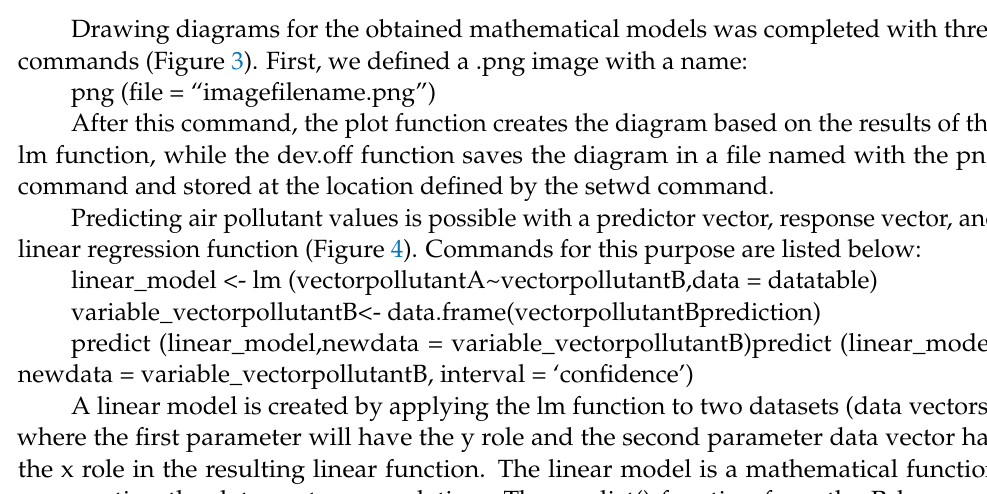
Figure 4. Created the second part of the R program, which deals with predicting air pollutants values, fitting the linear model, and printing the results.